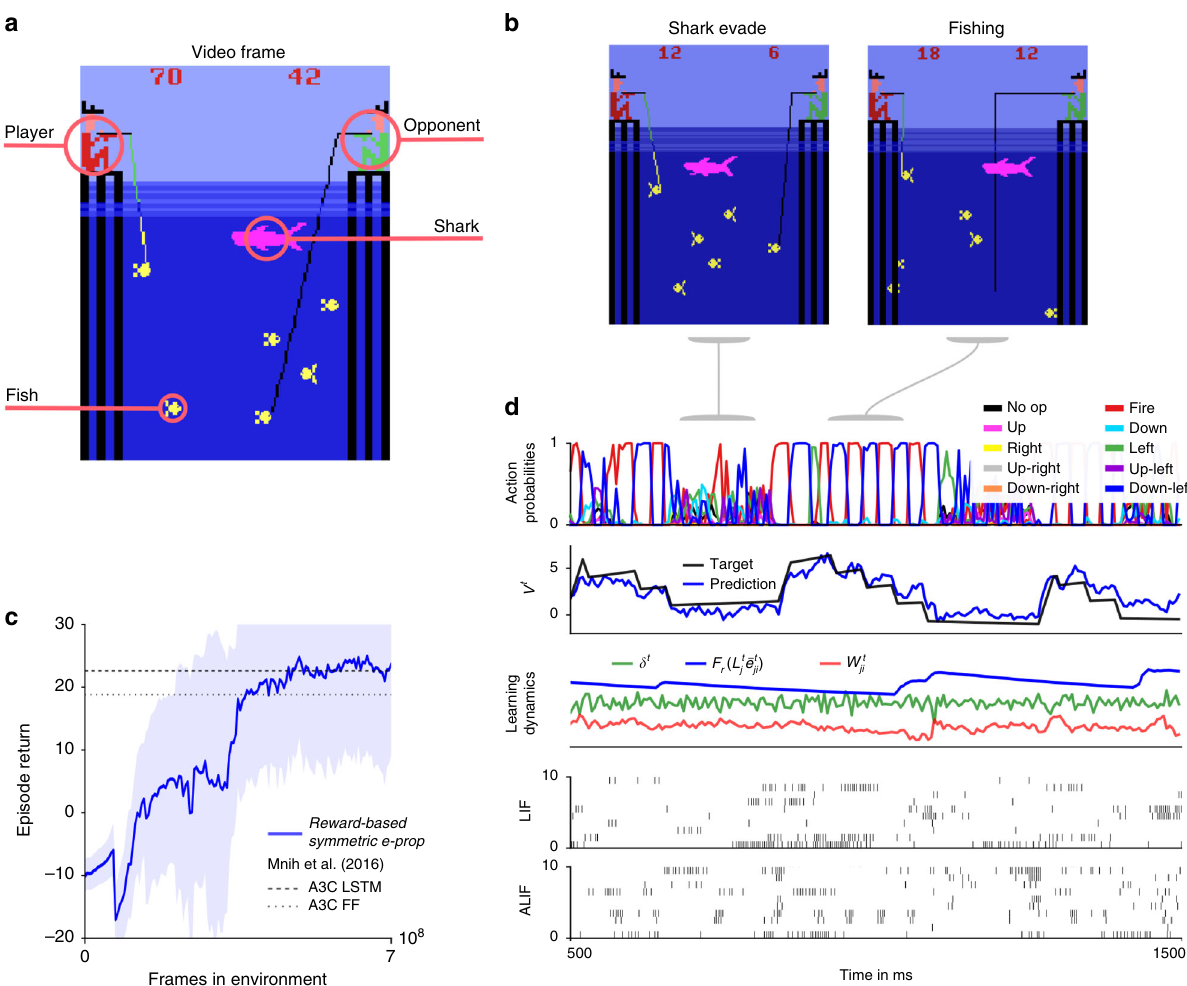
Fig. 5 Application of e-prop to learning to win the Atari game Fishing Derby. a Here the player has to compete against an opponent, and try to catch more fi sh from the sea. b Once a fi sh has bit, the agent has to avoid that the fi sh gets touched by a shark. c Sample trial of the trained network. From top to bottom: probabilities of stochastic actions, prediction of future rewards, learning dynamics of a random synapse (arbitrary units), spiking activity of 20 out of 180 sample LIF neurons and 20 out of 120 sample ALIF neurons. d Learning curves of an LSNN trained with reward-based e-prop as in Fig.